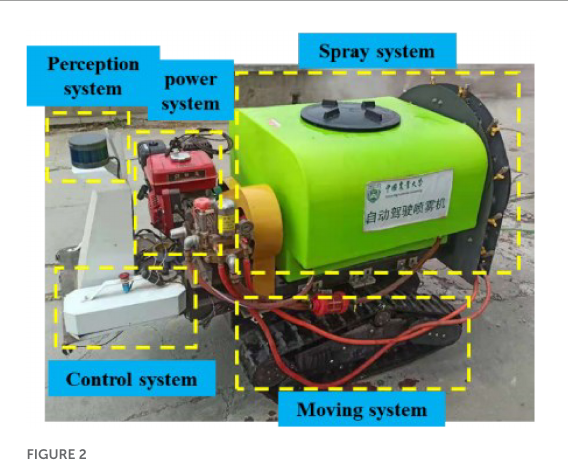
FIGURE2 Hardware module of orchard autonomous navigation spray